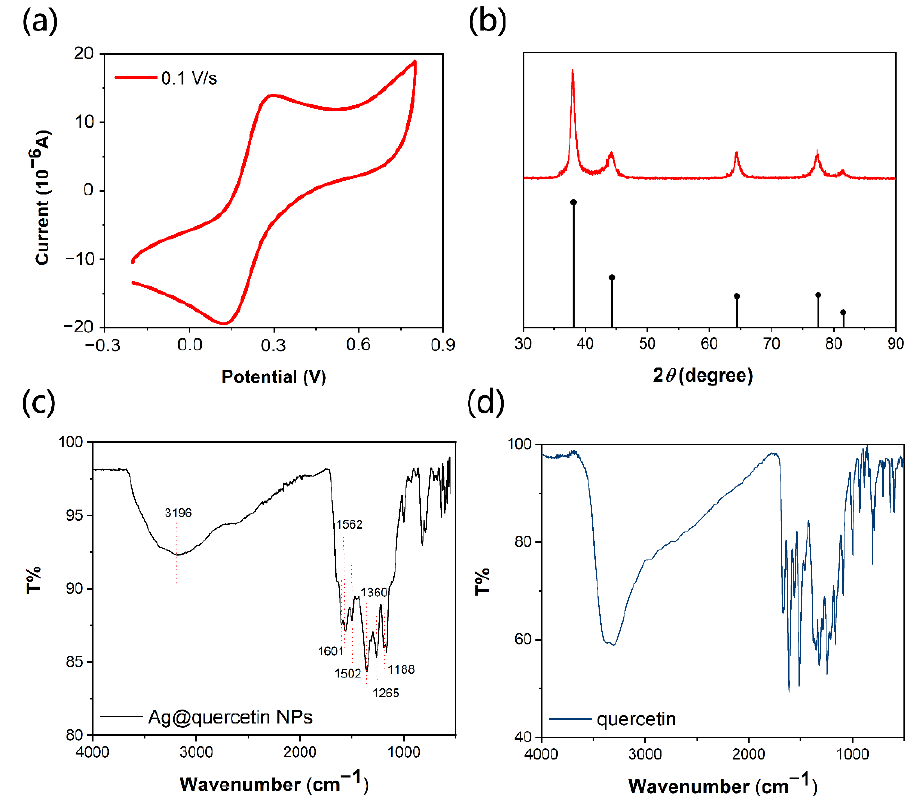
Figure 1. Structural characterization of QC and Ag@QCNPs. ( a ) Cyclic voltammogram of QC; ( b ) XRD spectrum of Ag@QCNPs (red) and standard of silver crystallite (black); FT-IR spectra of ( c ) Ag@QCNPs and ( d ) QC.